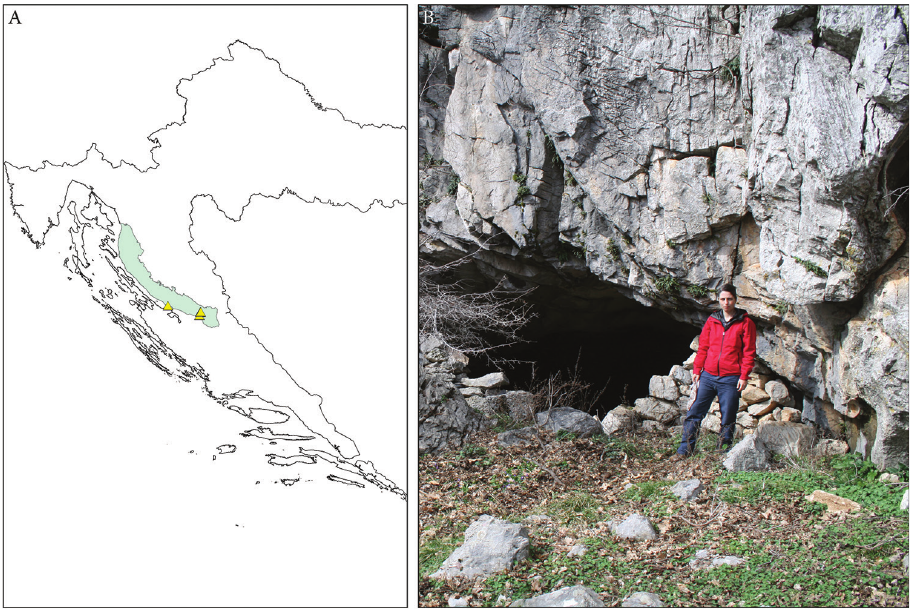
Figure 7. Occurrence of E. liburnicus sp. n. in Croatia. A Collecting sites (yellow triangle) B Entrance of the cave Plitka peć, type locality of E. liburnicus sp. n. (photo by K.